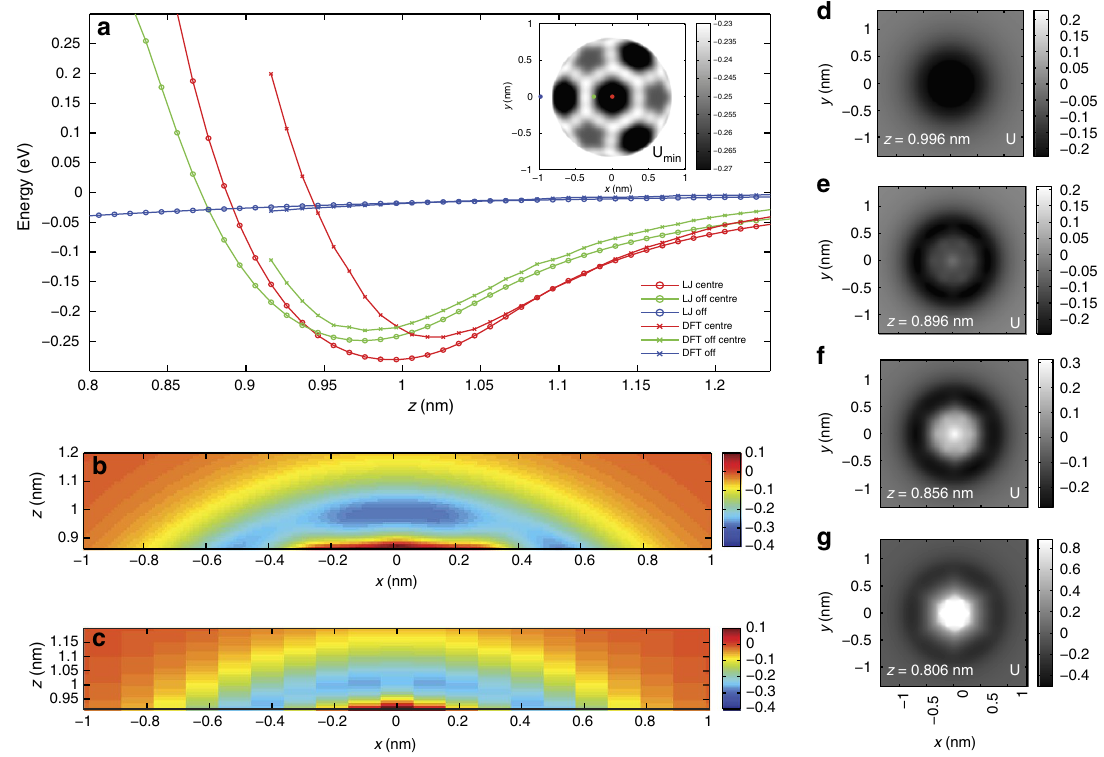
Figure 3 | Modelling the C 60 –C 60 interaction. ( a ) Comparison of potentials calculated by L–J modelling and DFT. z heights are defined as the vertical separation of the two molecules measured from the molecular centres. Curves are shown for the same initial xy coordinates in both simulations. Inset: Complete xy U min (in eV) image for L-J simulation. ( b , c ) xz plot of calculated energies for L-J and DFTsimulations, respectively. ( d – g ) Constant height xy energy images (in eV) from L–J simulations, relative heights labelled on each